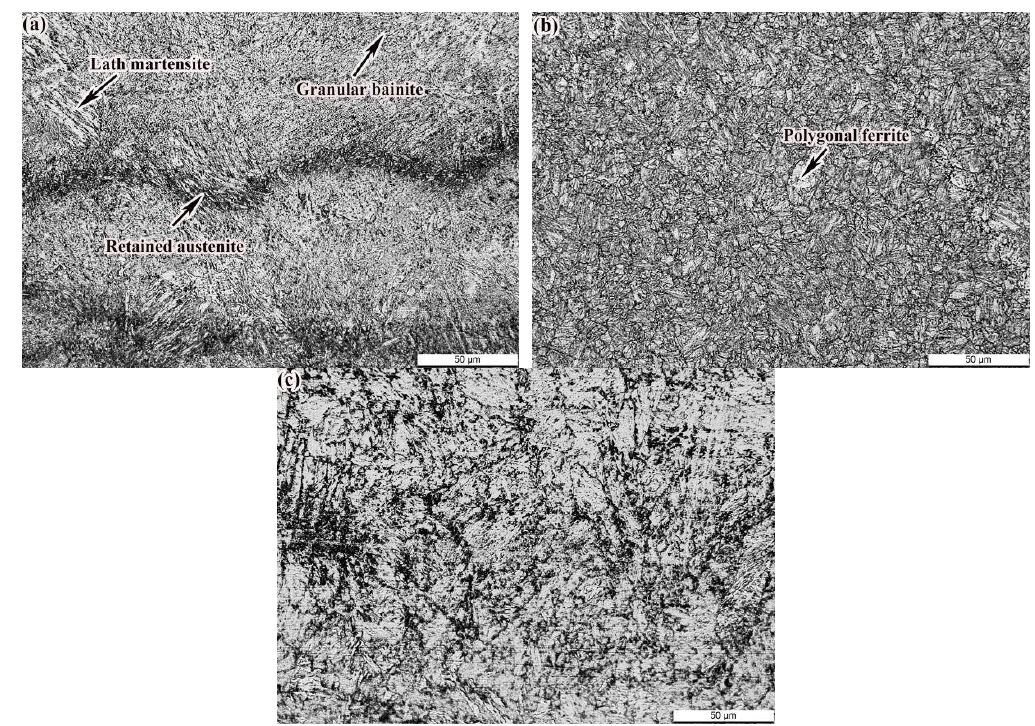
Figure 3. Microstructure in different states: ( a ) as-deposited; ( b ) quenched and tempered (QT); ( c ) and stress-relief annealed (SR).